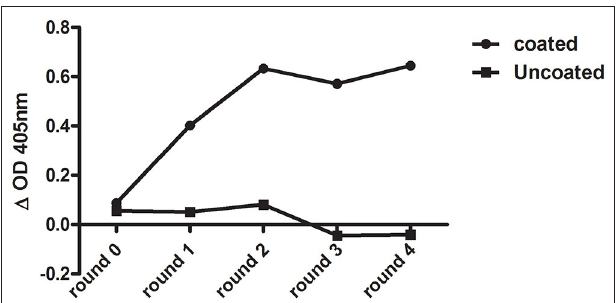
FIGURE 1 | Enrichment of Clec4F-specific nanobody after each round of bio-panning as measured by phage ELISA. Wells were coated with either 1 µ g/ml mouse Clec4F recombinant protein (coated), or only with PBS (uncoated). Output phages before panning (round 0) and after 4 rounds of biopanning were used as ligands in an ELISA.